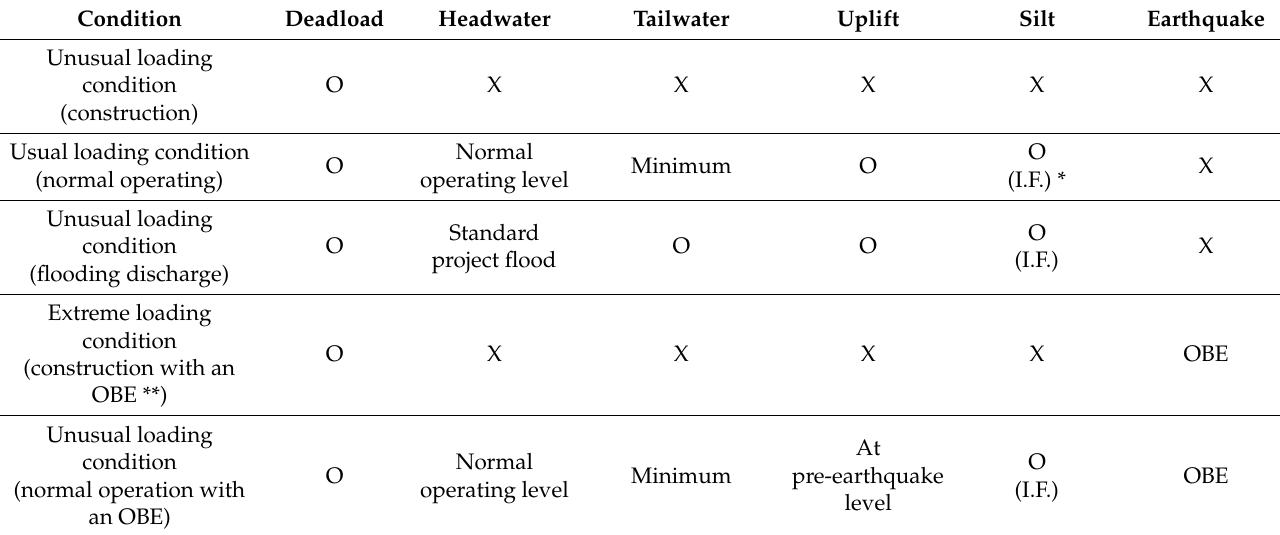
Table 2. Loading conditions and combinations for the